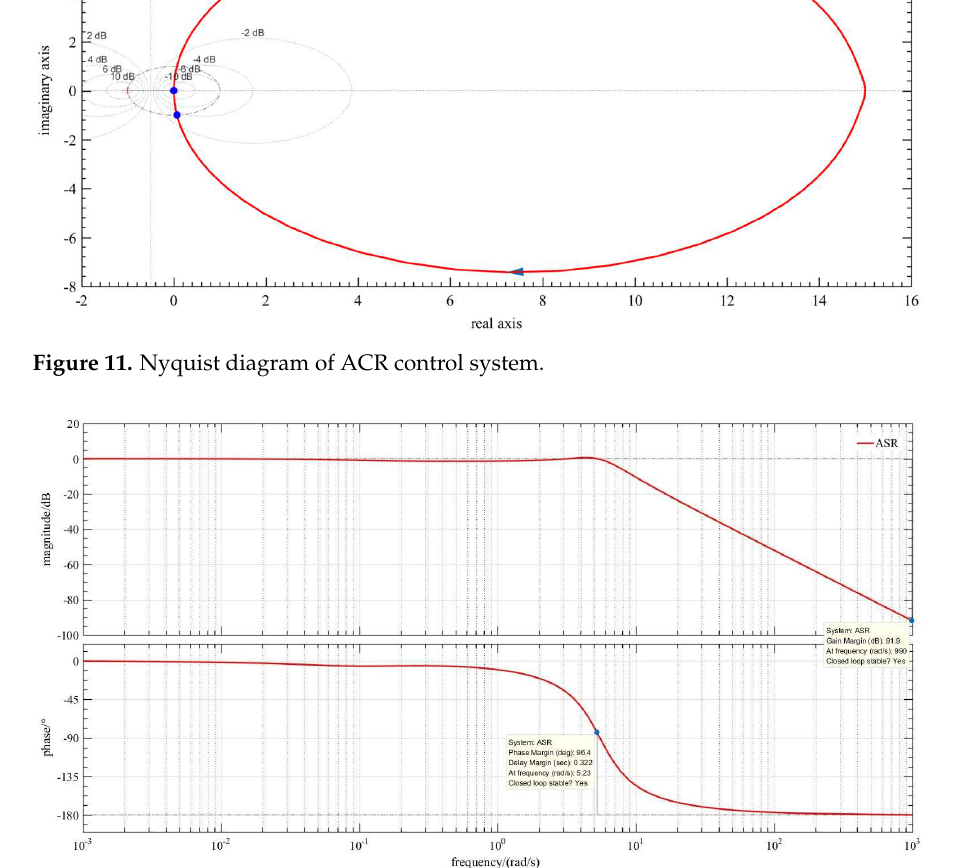
Figure 11. Nyquist diagram of ACR control system.